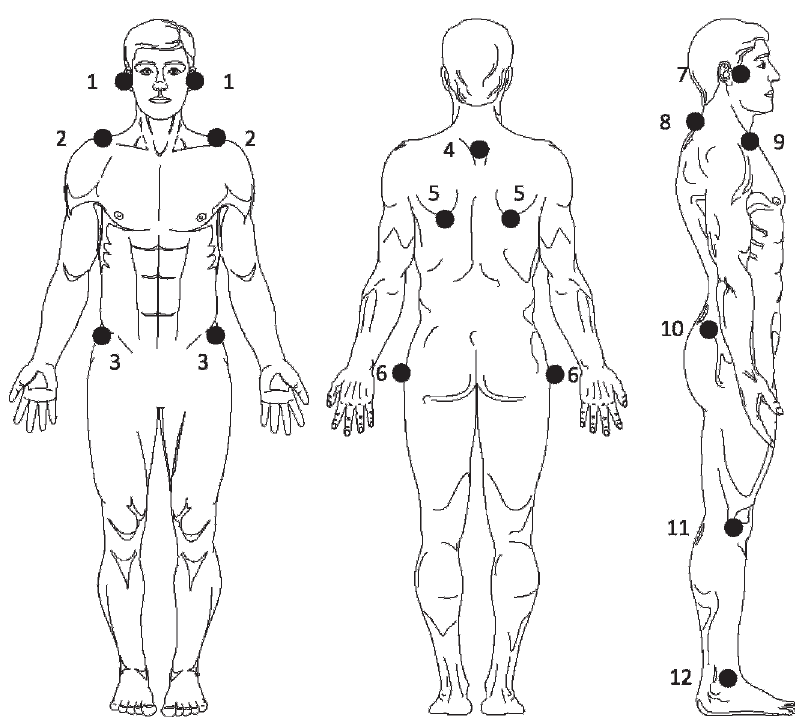
Figure 2 - Anatomical points that were evaluated by the PAS protocol: (1) tragus (anterior view); (2) acromion (anterior view); (3) anterior-superior iliac spine (ASIS); (4) spinal processes of the third thoracic (T3) vertebrae; (5) scapula (inferior angle); (6) greater trochanter; (7) tragus (lateral view); (8) spinal processes of the seventh cervical (C7) vertebrae; (9) acromion (lateral view); (10) posterior-superior iliac spine; (11) knee (articular line); and (12)